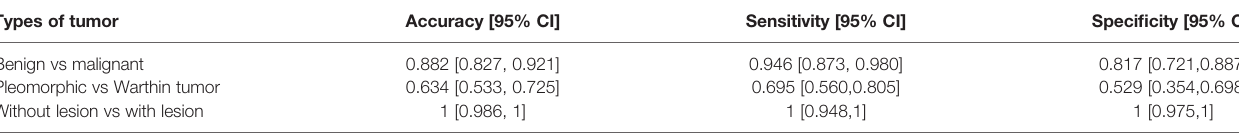
TABLE 4 | Parotid gland tumor classi fi cation results for different types of tumors in a single MR slice. Types of tumor Benign vs